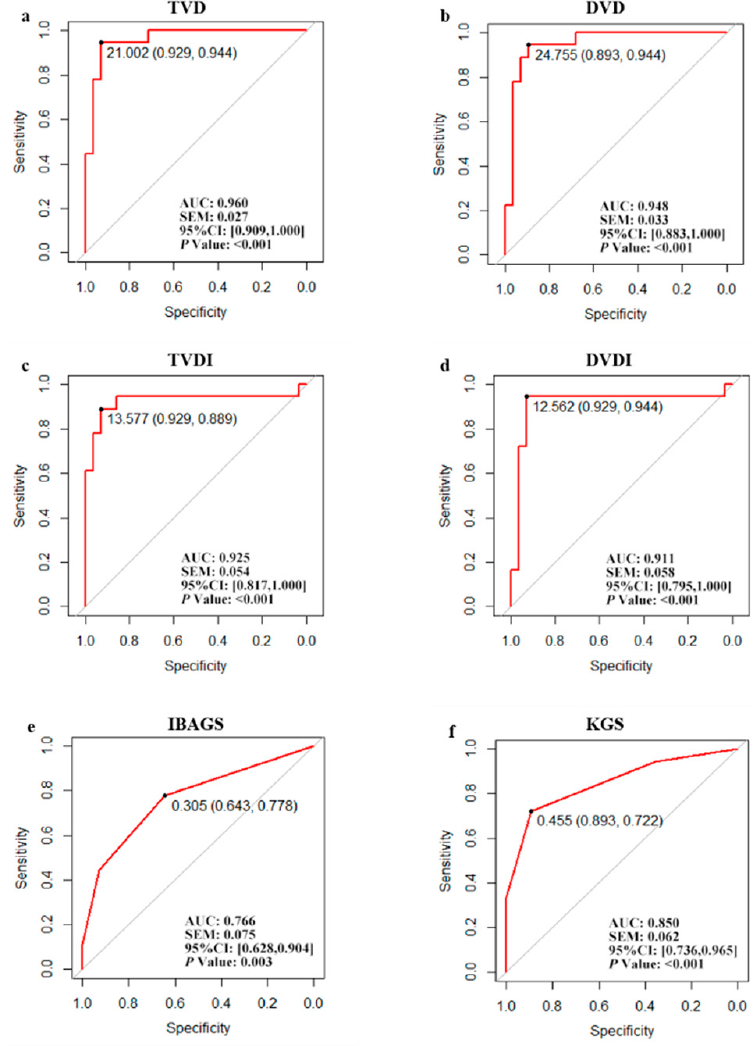
Figure 5. ROC for vessel parameters acquired using anterior segment optical coherence tomography angiography, IBAGS, and Kenfeld grading system. ( a – d ) ROC for TVD, DVD, TVDI, and DVDI. ( e ) ROC for IBAGS; ( f ) ROC for KGS. ROC = Receiver operating characteristic curve. AUC = area under curve. TVD = Tenon’s vessel density. TVDI = Tenon’s vessel diameter index. DVD = deep-vessel density. DVDI = deep-vessel diameter index. IBAGS = Indiana Bleb Grading Appearance Scale. KGS = Kenfeld grading system. Table 6. The influence of prostaglandin administration on vasculature parameters.